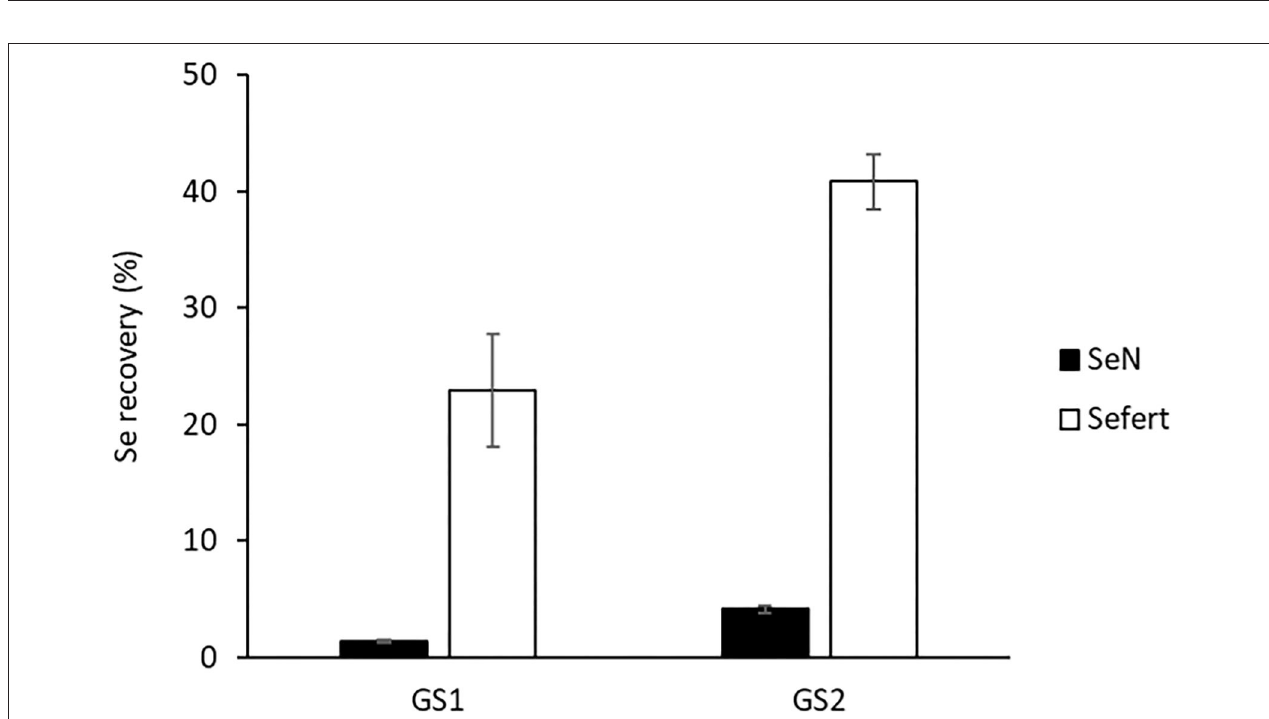
FIGURE 1 | Partitioning of applied foliar Sefert ( ± N) in the aboveground biomass of plants as a function of harvest time [3, 10, and 17/34 days after application at stem elongation, GS1 (A) /heading stage, GS2 (B) ]. The recovery of applied Sefert was calculated as the percentage of applied fertiliser Se that was recovered in the aboveground plant parts. Note that at H34, wheat heads were hand threshed to separate grains and chaff.